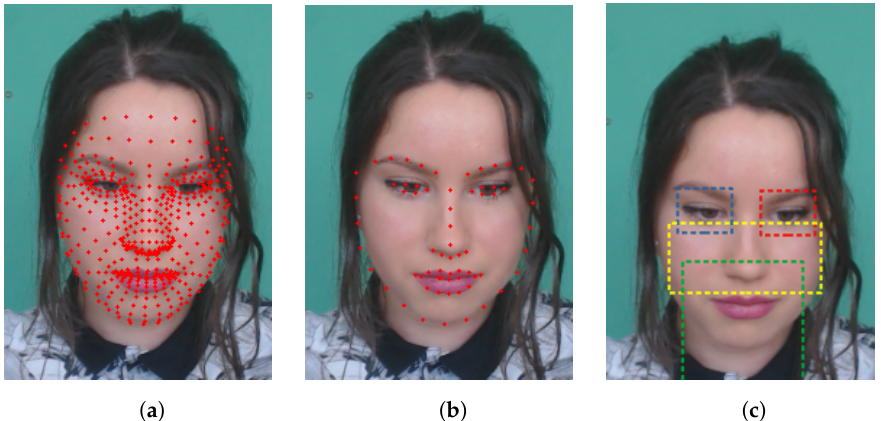
Figure 2. Images from the first subject of the dataset UBFC. ( a ) Facial features detected by FaceMesh. ( b ) Facial features detected by SVM. ( c ) Regions of interest that were